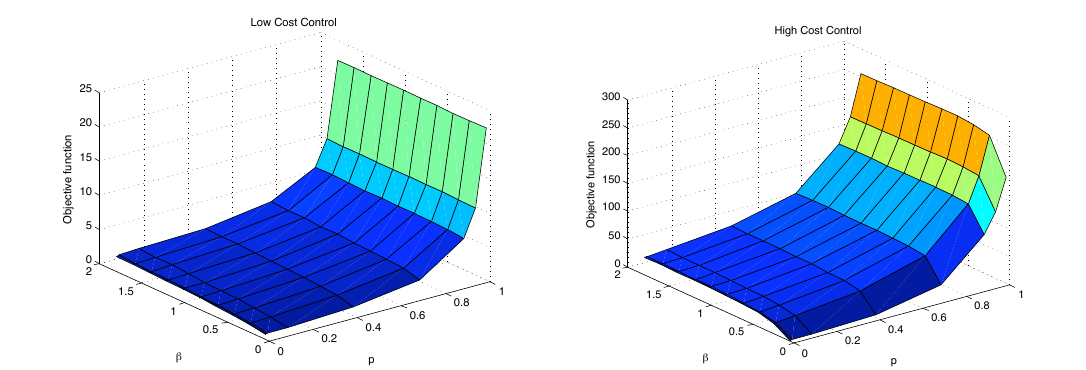
( a ) If the control function is inexpensive, w ( b ) If the control is expensive w 3 = 0.01, 3 = 2, but not then outbreak can be controlled while keeping the prohibitively so, then the control function will still be objective function small unless there is a high effective, but the objective function will be very expensive, proportion of mosquitoes becoming infected vertically. especially for large values of vertical transmission. Figure 7. Even with an “effective” control program, a high vertical transmission rate can render the health policy moot regardless of the cost of additional control is low ( a ), or high ( b ).